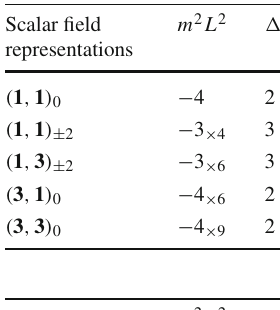
Table 2 Scalar masses at the N = 4 supersymmetric AdS 5 critical point with U ( 1 ) × SU ( 2 ) diag symmetry and the corresponding dimensions of the dual operators